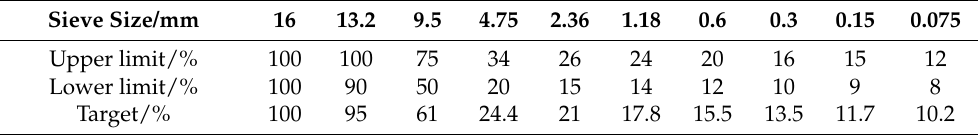
Table 4. SMA13 gradation.